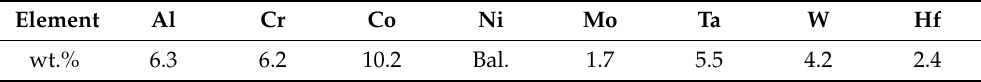
Table 1. Main chemical compositions of the serviced turbine blade